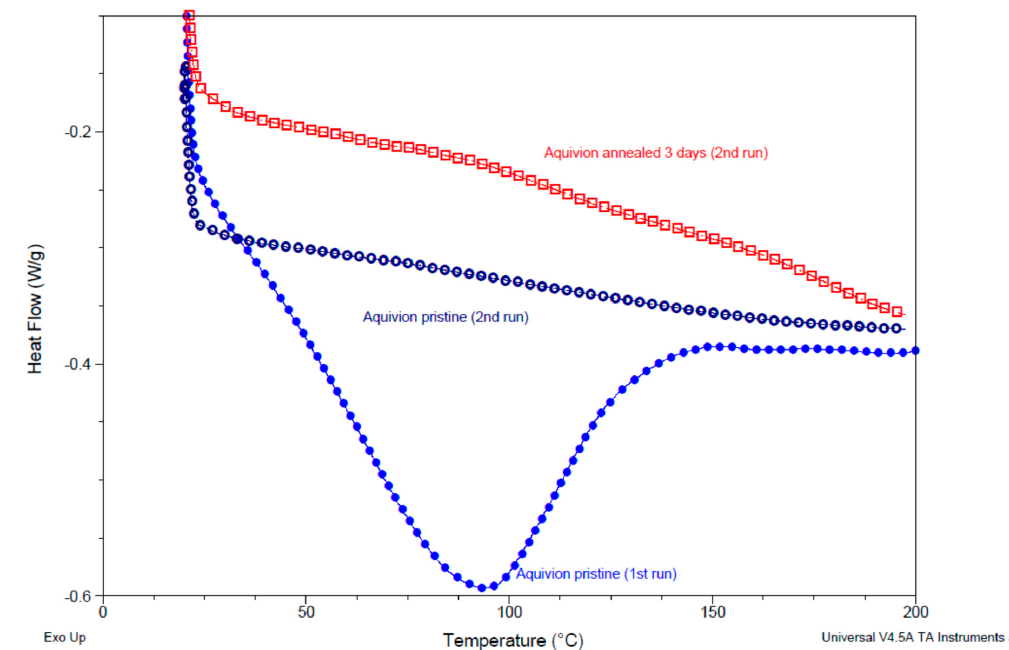
Figure 7. Differential scanning calorimetry (DSC) curves of Aquivion ® 870 before ( blue ) and after annealing at 140 °C in presence of DMSO for 3 days ( red ).